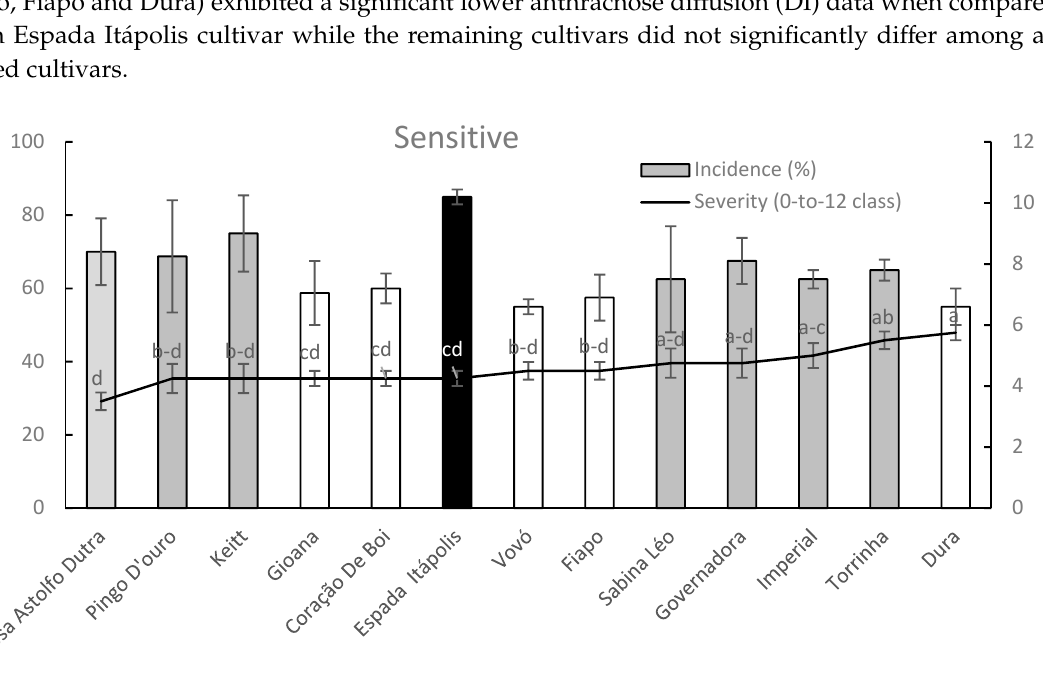
Figure 8. Column-line graphs on two axes comparing anthracnose incidence and severity caused by C. asianum within moderately sensitive mango cultivars. Data (± SE values) were collected and analyzed as above done for previous figures. Grey colors of columns, as well as the absence of letters above points of the line, clearly show the lack of significant differences according to both parametric and nonparametric approaches.